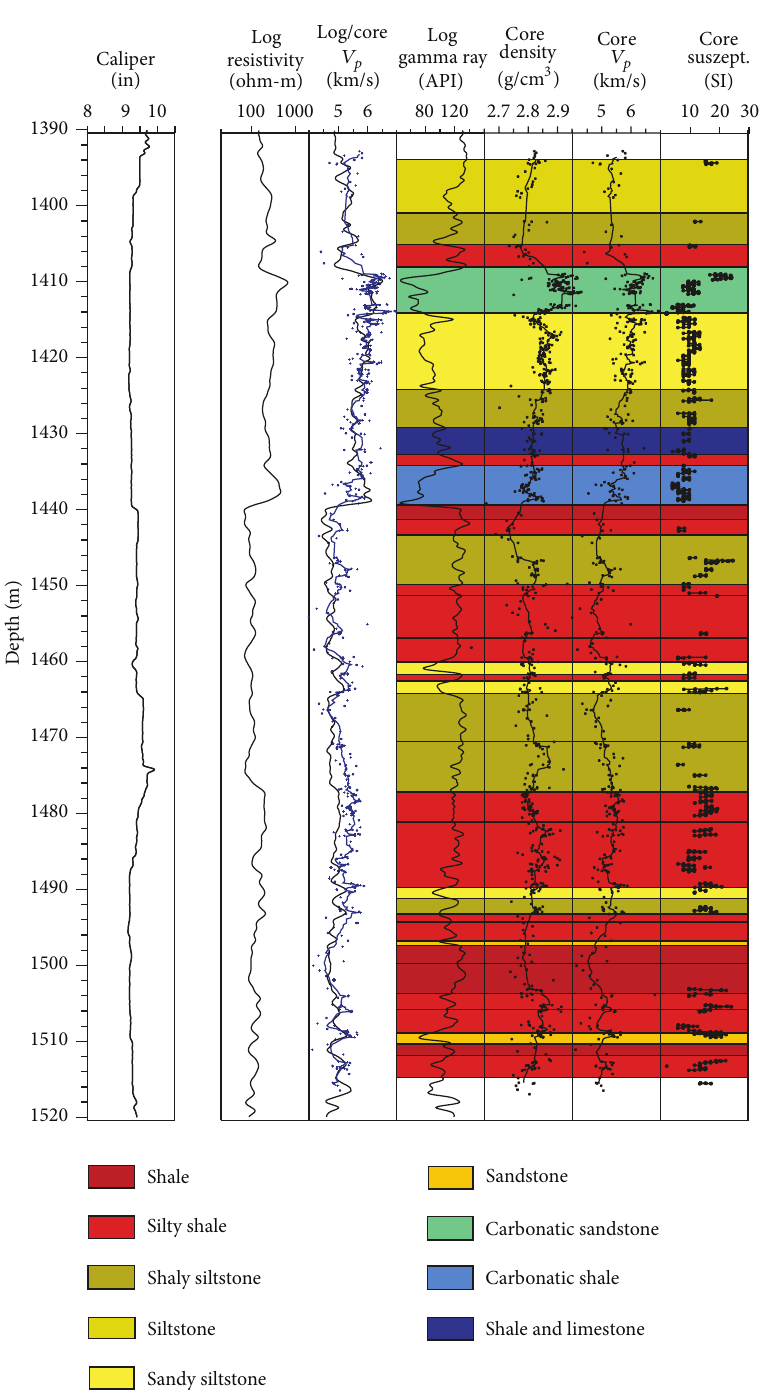
Figure 6: Petrophysical core data (right) and on the left borehole log data (left) for the RWTH-1 borehole; (i) on the right, dots indicate the core measurements and the black lines are sliding window average of the core measurements; (ii) on the left, the black lines are borehole logs and the blue line shows the sliding window average of the core measurements. Colors indicate rock type according to the petrographic core description [1,